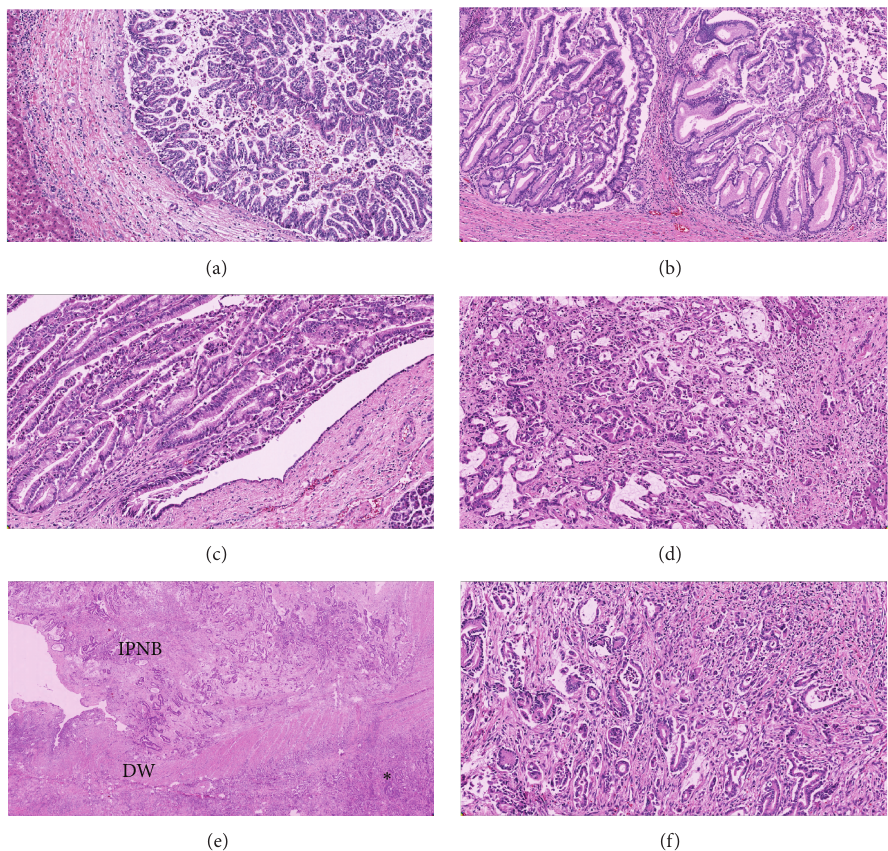
Figure 4: Micrographs. (a–c) Intraductal papillary lesions: (a) intrahepatic bile duct: IPNB with carcinoma in situ ; (b) common bile duct: low-grade IPNB; and (c) main pancreatic duct: low-grade IPMN. (d–f) Invasive lesions: (d) mucin-producing tubular adenocarcinoma from invasive IPNB lesion at S4 of liver; (e, f) invasive carcinoma from distal common bile duct; (e) invading carcinoma at the duodenal wall (DW) from the intraductal lesion of the distal common bile duct (IPNB), invasive tumor at duodenal wall ( ∗ ), highlighted in (f) showing moderately differentiated tubular adenocarcinoma. Original magnification: (a–c) × 100, (d, f) × 200, and (e) ×